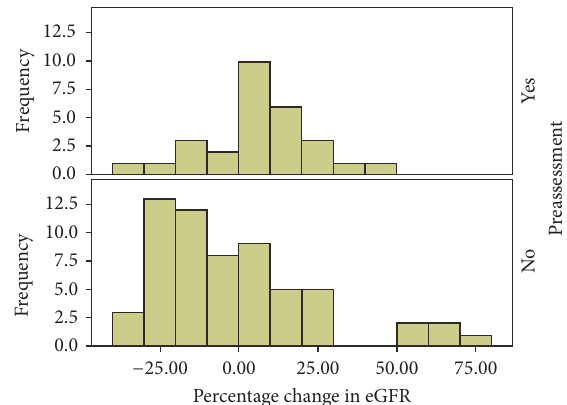
Figure 1: Percentage change in eGFR in patients with or without preassessment. eGFR: estimated glomerular filtration